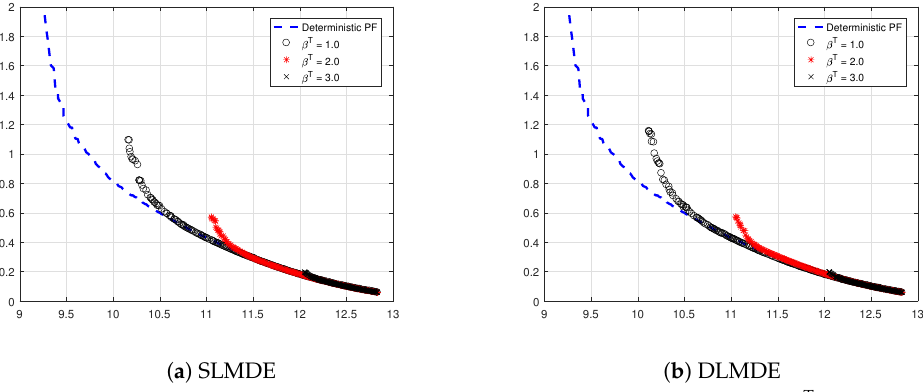
Figure 8. The PO solutions obtained via both methods for example 4 for different β T values.